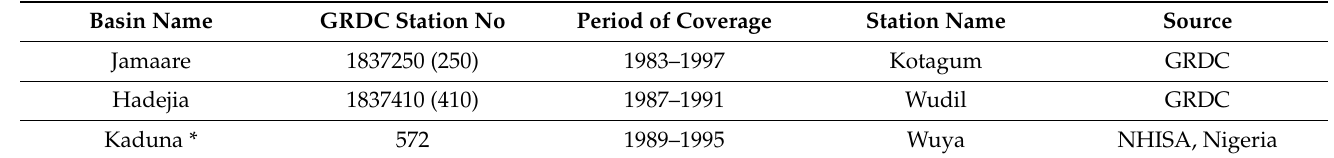
Table 2. Daily discharge